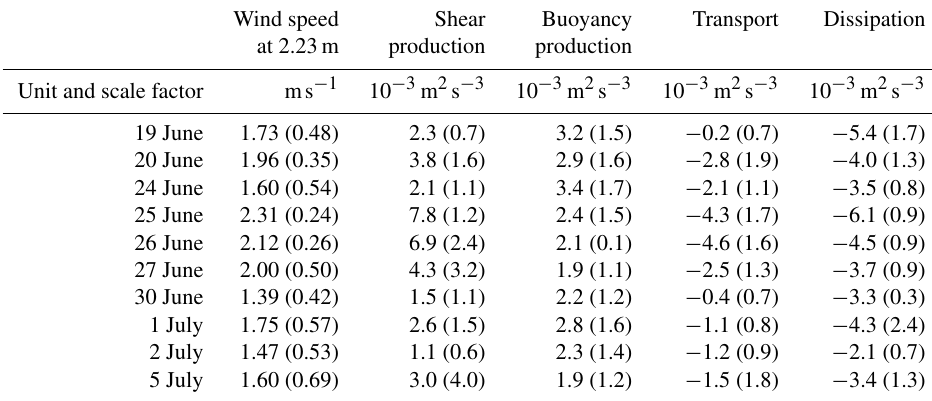
Table B1. Afternoon statistics of wind speed, shear production, buoyancy production, transport and dissipation for a measurement height of 2.23m. Here, the mean value (and standard deviation) for each afternoon period was calculated from the hourly TKE budget results presented in Fig. 5. Note the scale factor of 10 − 3 for the TKE budget terms.